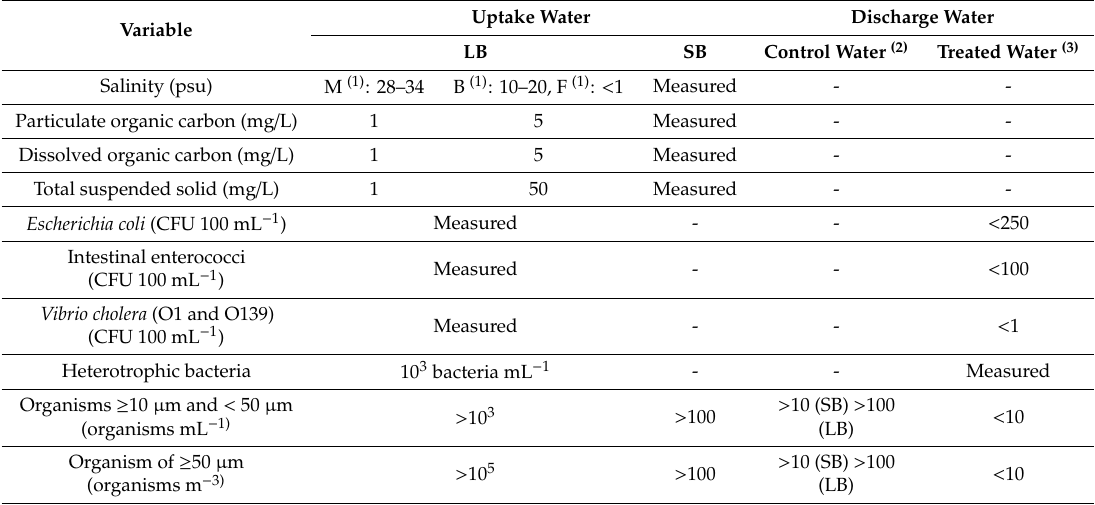
Table 1. Minimum criteria for land-based (LB) and shipboard (SB) testing. Uptake Water Discharge Variable